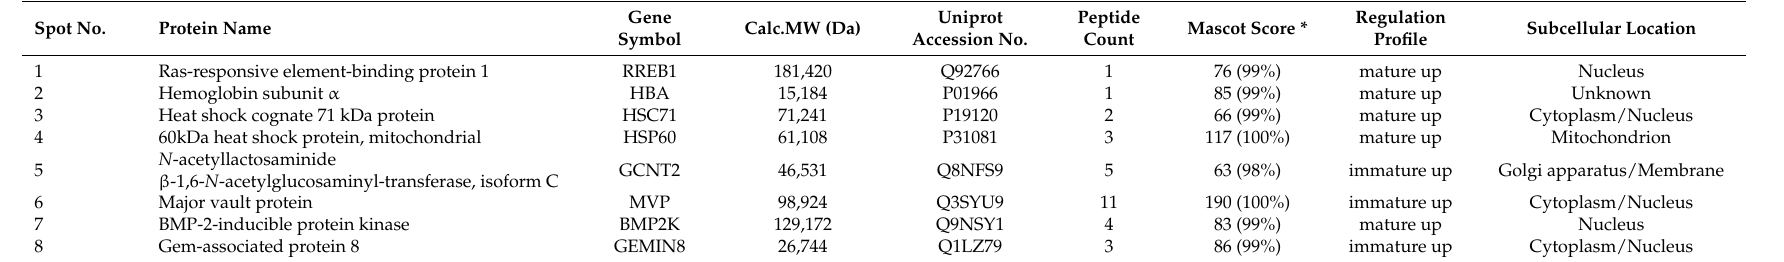
Table 1. The identification of proteins by MALDI-TOF/TOF mass